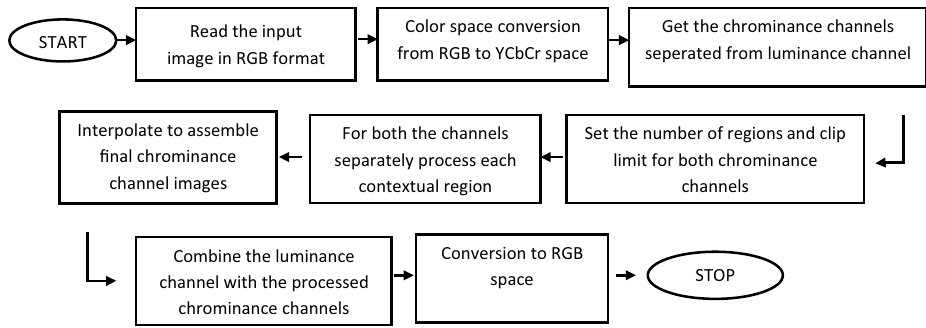
Fig. 8. Flow chart for CLAHE